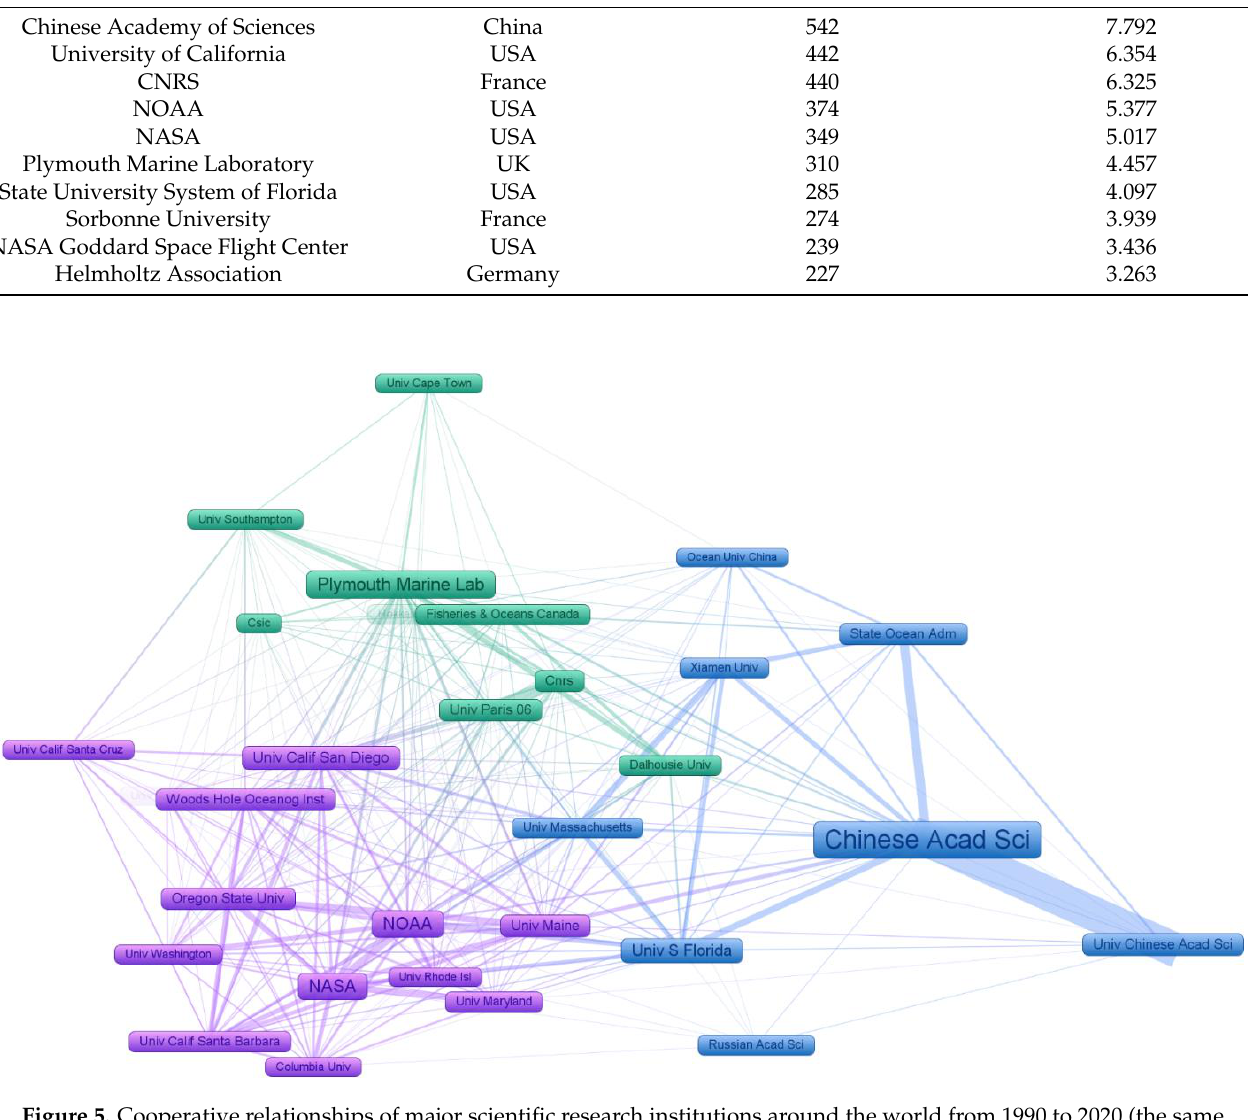
Figure 5. Cooperative relationships of major scientific research institutions around the world from 1990 to 2020 (the same color in the figure indicates the most closely related cooperation group; the size of the box indicates the number of papers that were published by the institution, with a larger box indicating more papers; and the connection between institutions indicates the intensity of cooperation, with a thicker connection indicating a closer cooperative relationship).